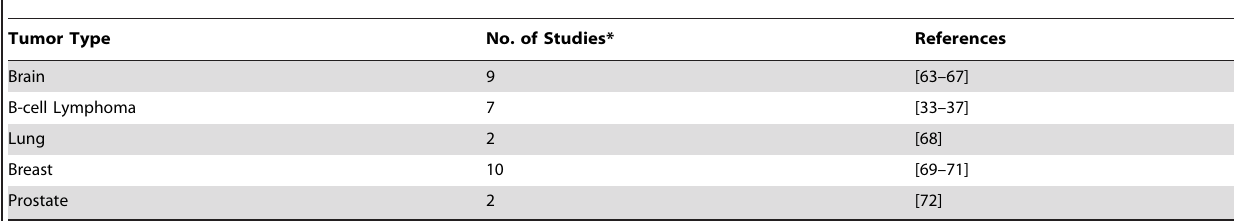
Table 1. Reduced NIAM mRNA levels in cancer